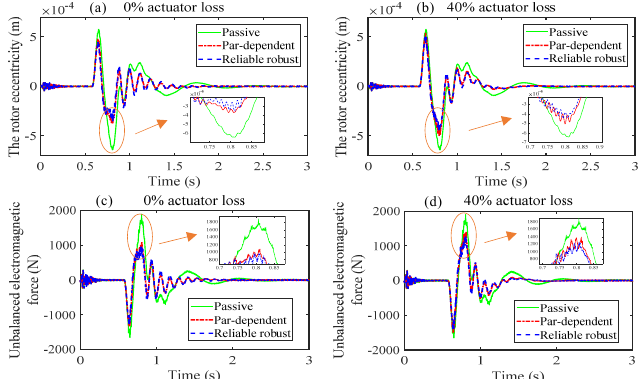
Figure 16. The in-wheel motor dynamic responses: ( a ) the rotor eccentricity under 0% actuator loss; ( b ) the rotor eccentricity under 0% actuator loss; ( c ) UEF under 0% actuator loss; ( d ) UEF under 40% actuator loss.